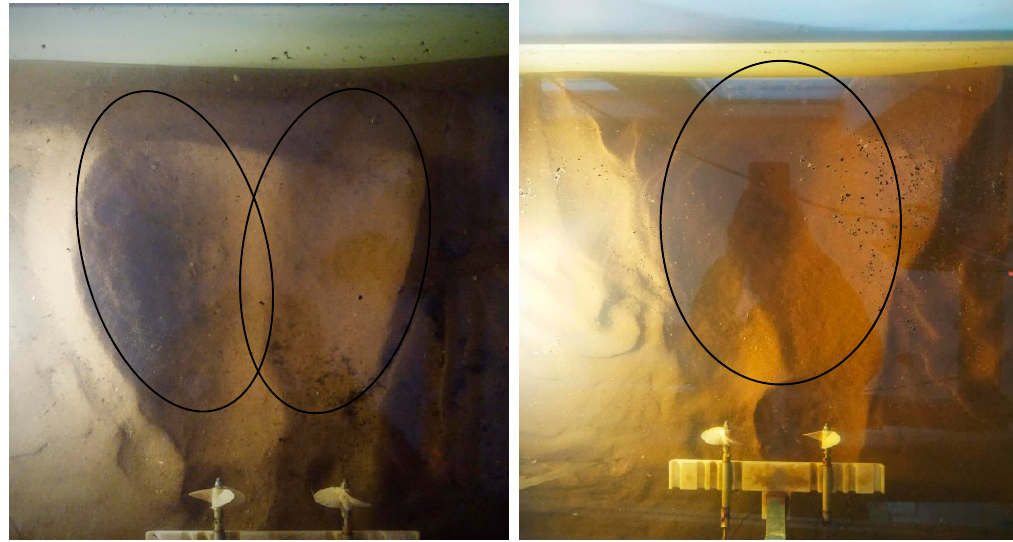
Figure 4. ICRTP and ECRTP wall scour structures.